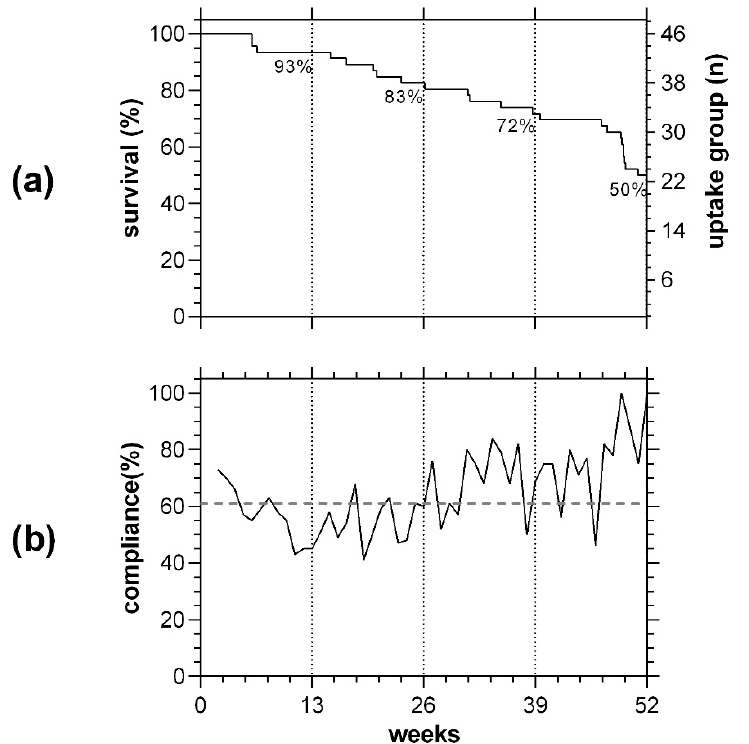
Figure 4. Survival and compliance of n = 46 iAMD participants to the request for MRFh over a 52-week period. ( a ). Survival of participants over 52 weeks of MRFh. ( b ). Compliance rate to weekly testing (7 + 1 days, solid line). Dotted line represents average compliance rate over the 52-week period.